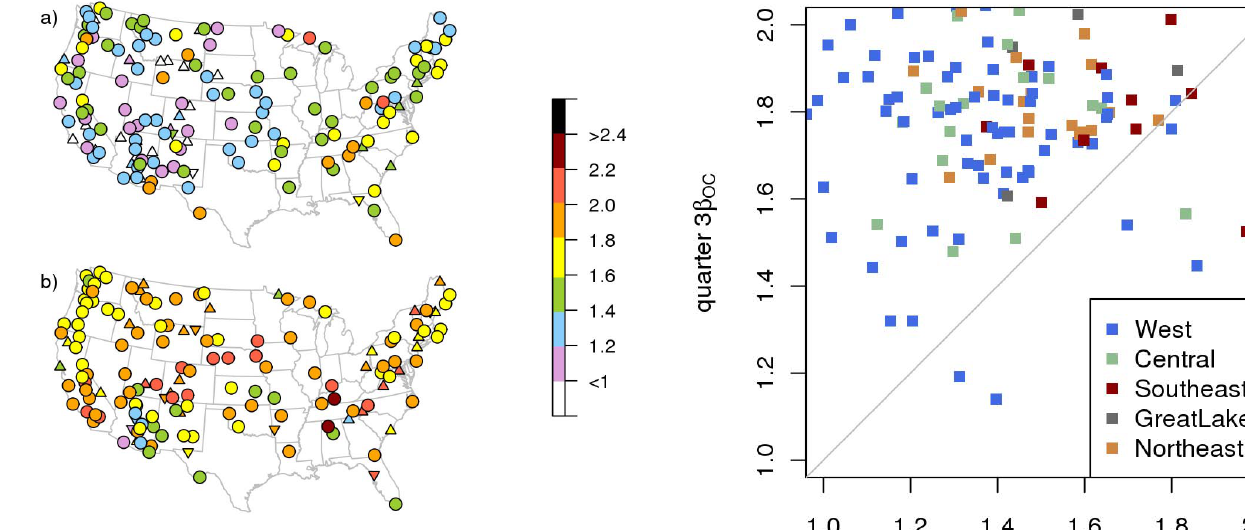
Fig. 11. β OC values for quarter 1 (top) and quarter 3 (bottom). High confidence results are depicted by circles, regressions with ques- tionable residual trends are depicted by downward facing triangles, and regressions with any physically unreasonable coefficient are de- picted by upward facing triangles.